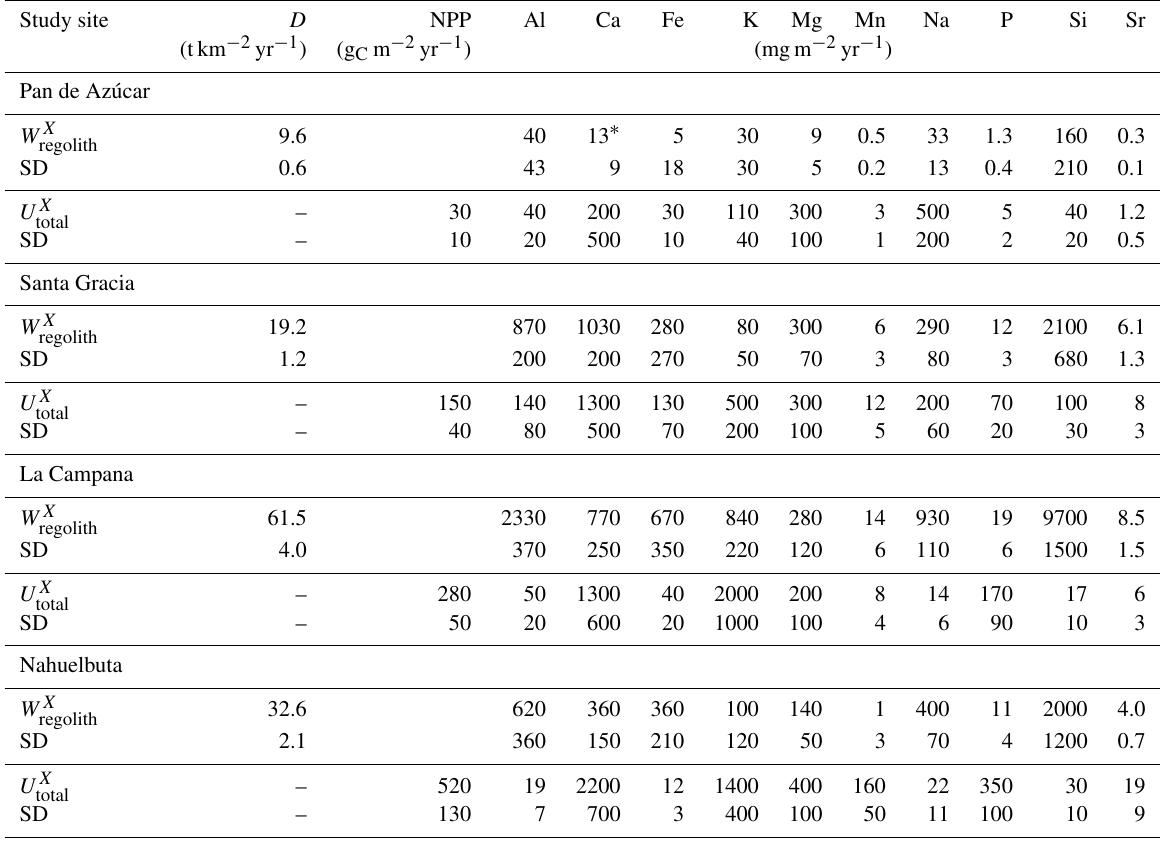
Table 3. Elemental weathering fluxes ( W X ) and ecosystem nutrient uptake fluxes ( U X ) in Pan de Azúcar, Santa Gracia, La Campana, regolith total and Nahuelbuta along with the respective study site’s average soil denudation rate ( D ) and net primary productivity (NPP).